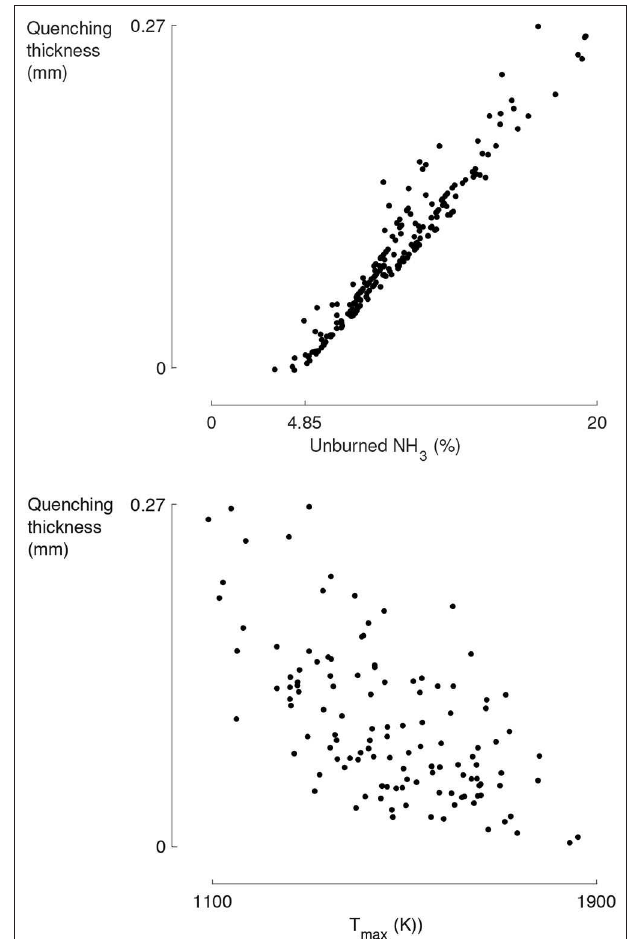
FIGURE 17 | The quenching thickness spans for all the experimental runs from 0 to 0.27 mm as the unburned ammonia fraction increases from 4.85 to 20% (left) and as the maximum combustion temperature spans from 1,100 to 1,900 K (right) . A maximal combustion temperature above 1,700 K shall help minimizing the crevice unburned fuel given the crevice